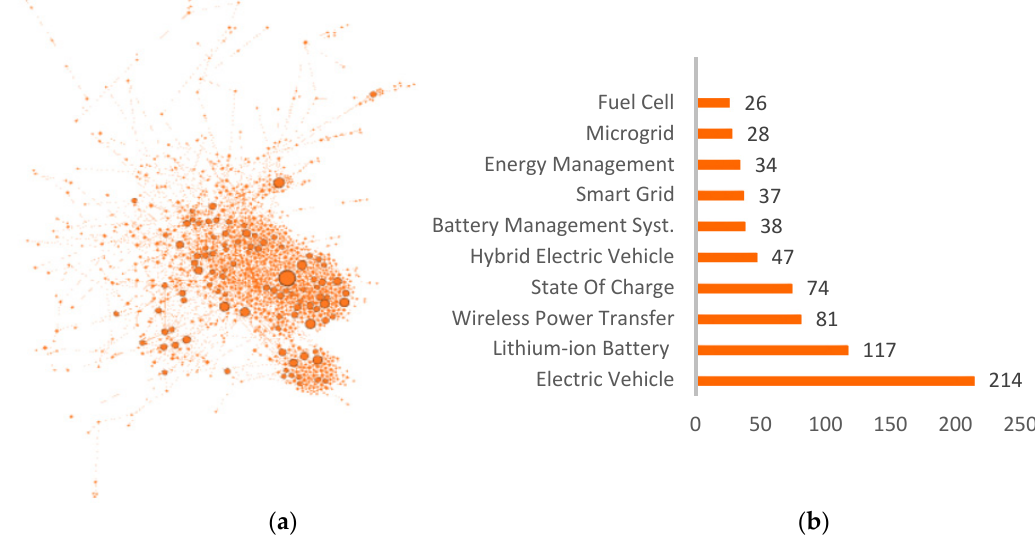
Figure 14. Energy storage: ( a ) manuscripts published, ( b ) keywords.